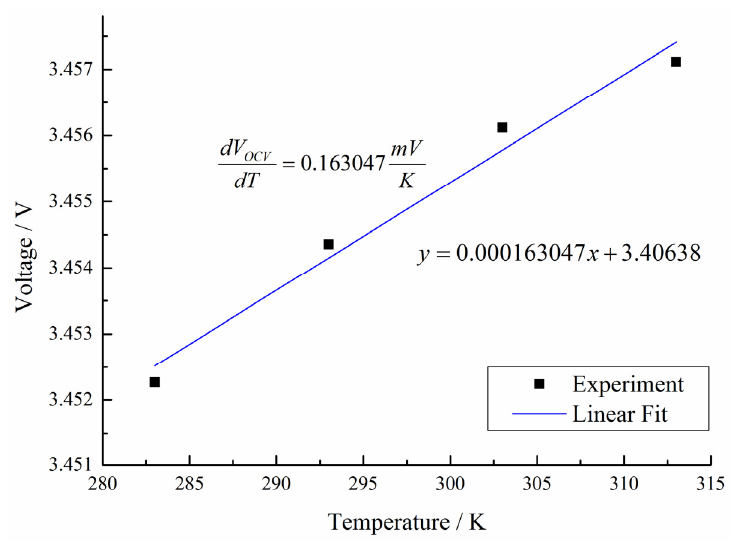
Figure 5. Entropy coefficient for SOC = 100%.